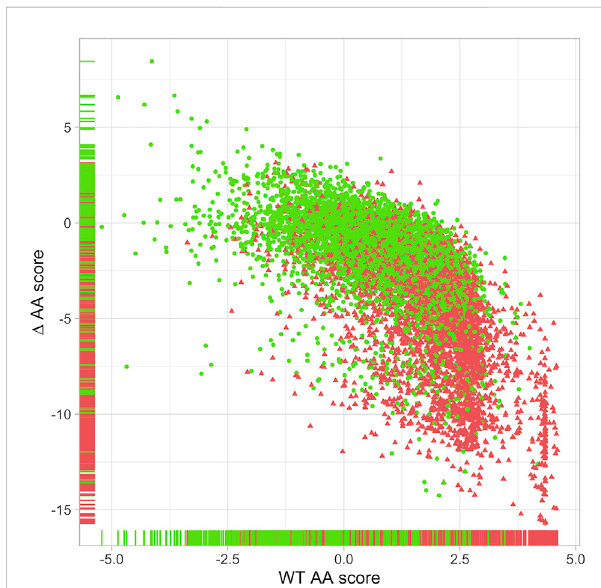
FIGURE 1 Distributionofthe9,121ClinVarvariationswithaqualityofatleast two stars located in protein domains. X -axis = DOLPHIN “ wt ” scores; Y -axis = DOLPHIN “ Δ ” scores. Red triangles = ClinVar Class 4 & 5 variations ( n = 4,382). Green dots = ClinVar Class 1 & 2 variations ( n = 4,739). Horizontal and vertical bands on X and Y -axis represent the corresponding “ wt ” and “ Δ ” values of each variation according to their type: red for pathogenic variations (class 4 & 5) and green for neutral variations (class 1 & 2).